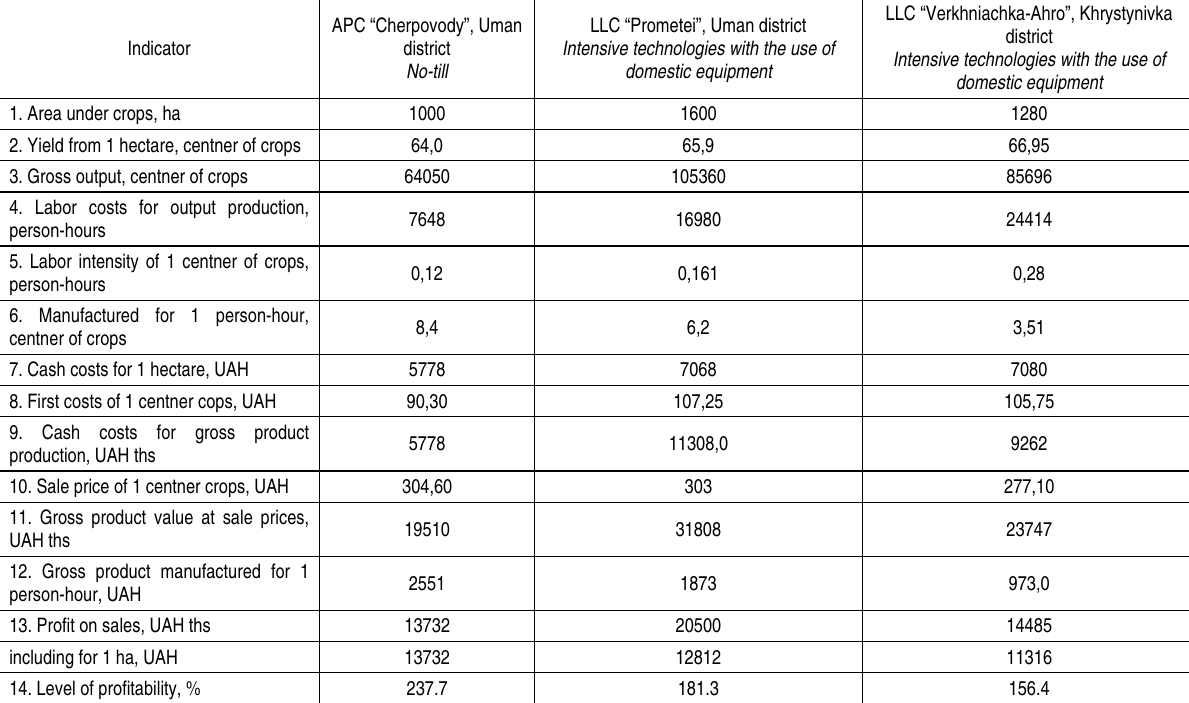
Table 7. Economic efficiency of crop rotation at the enterprises